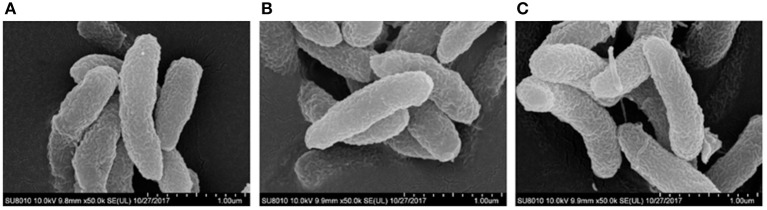
Scanning electron microscopy of V. cholerae strains C6706 (A), C6706-ΔompW
(B), and C6706-ΔompW/compW
(C).